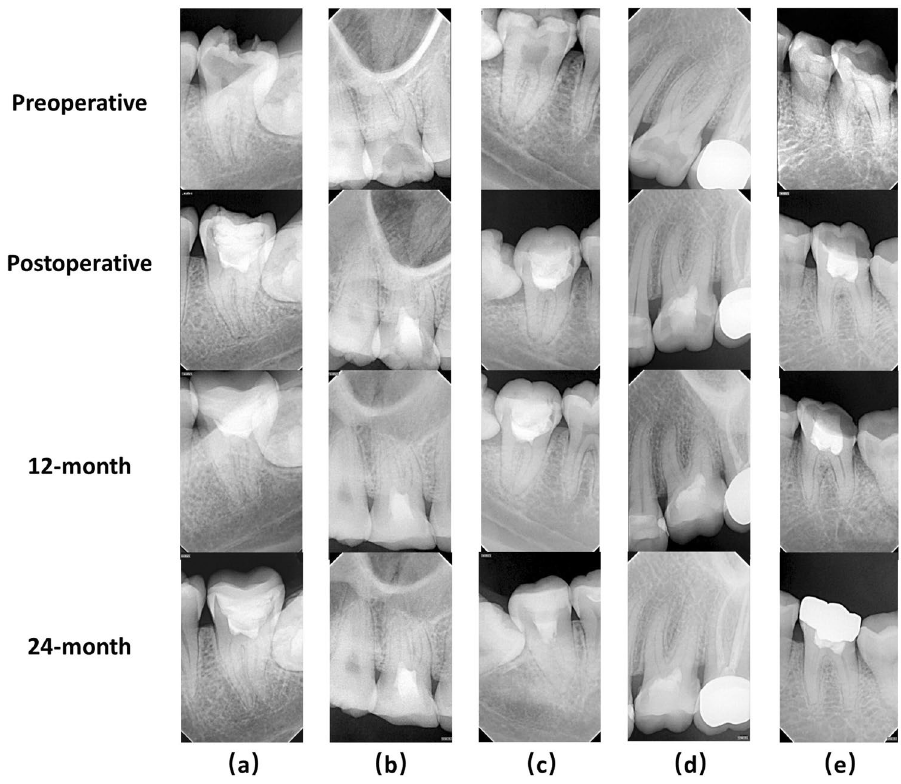
Figure 4. Radiographs of five pulpitis teeth included in this study. Radiographs that taken before, and immediately after the pulpotomy, at 12-month and 24-month follow-ups were shown. No obvious root canal calcification was found during the review compared to the preoperative radiographs. ( a ) Radiographs of a left mandibular second molar. ( b ) Radiographs of a right maxilla first molar. ( c ) Radiographs of a right mandibular second molar. ( d ) Radiographs of a left maxilla first molar. ( e ) Radiographs of a left mandibular first molar.